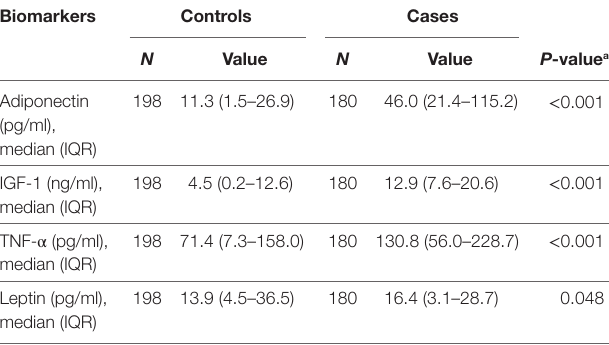
( Table 1 ). All controls’ sera were drawn from African Americans undergoing colonoscopy under the same condition as